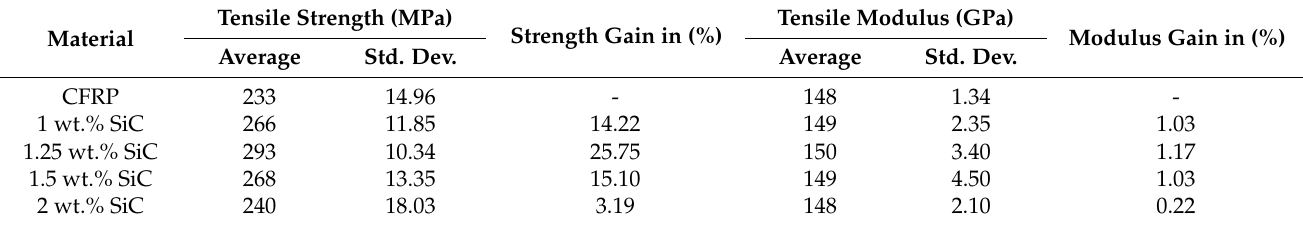
Table 4. Tensile properties of CFRP and hybrid SiC nano-composites.